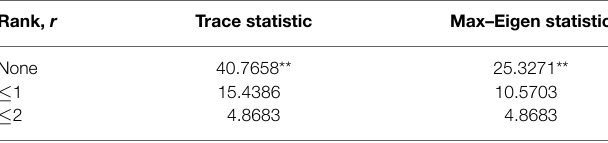
TABLE 2 | Johansen and Juselius cointegration test